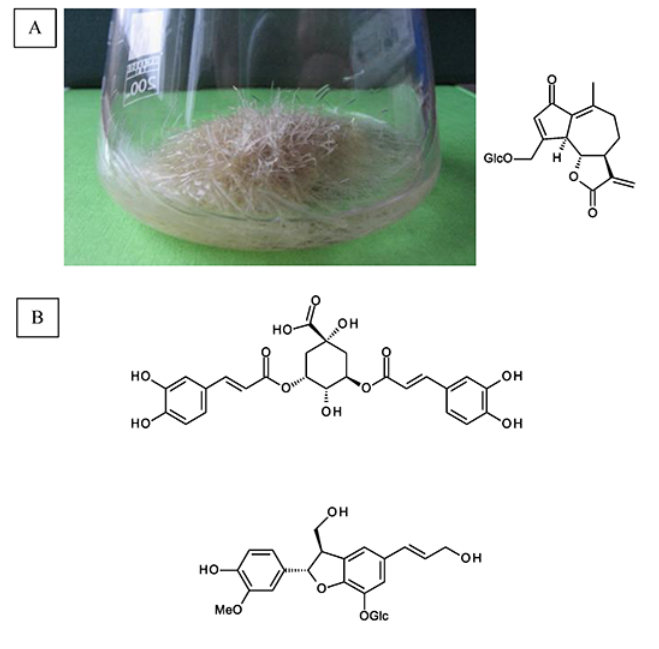
Figure 20 ( A ) Rhizobium rhizogenes LBA 9402-transformed Cichorium intybus L. root